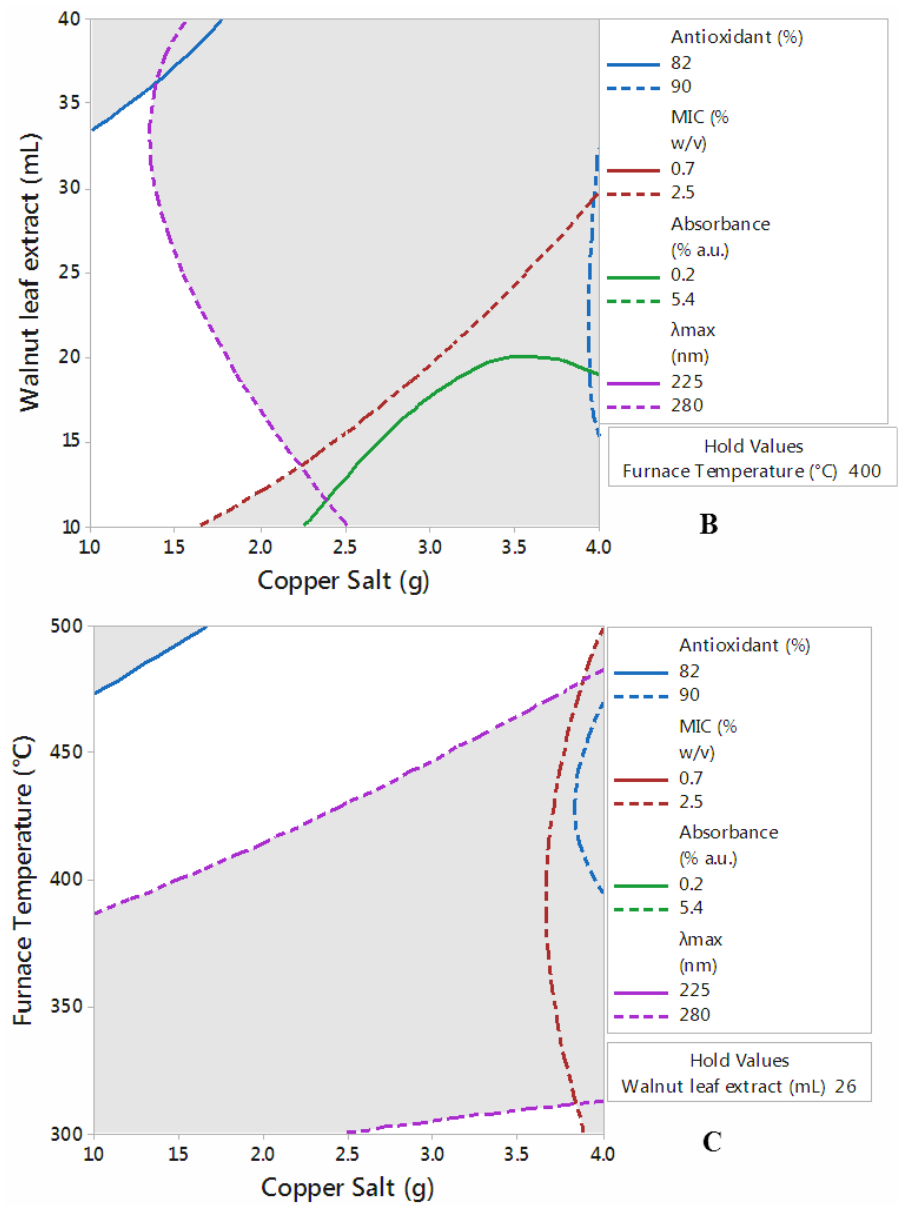
Figure 4: (a-c) Overlaid contour plot CuO NPs λmax, absorbance, antioxidant activity and MIC with acceptable levels as function of copper salt amount (g), amount of walnut leaf extract (mL) and furnace temperature